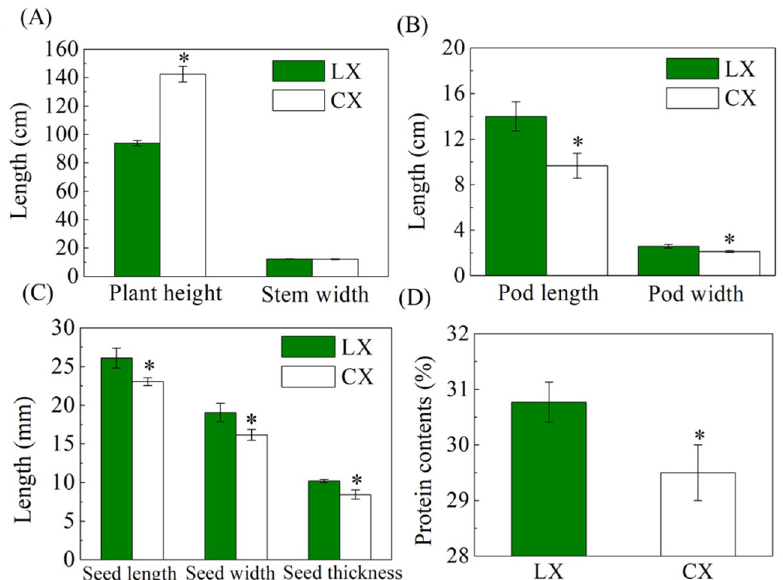
Figure 2. Comparison of ( A ) plant height and stem width, ( B ) pod length and pod width, ( C ) seed length, seed width, and seed thickness at maturity, and ( D ) dry seed protein content between Cixidabaican (CX) and Lingxiyicun (LX). Data are the mean of the two years of data of Year 1: 2018–2019 and Year 2: 2019–2020. * Represents significant difference by Student’s t -test at p ≤ 0.05. Error bars represent SD value.